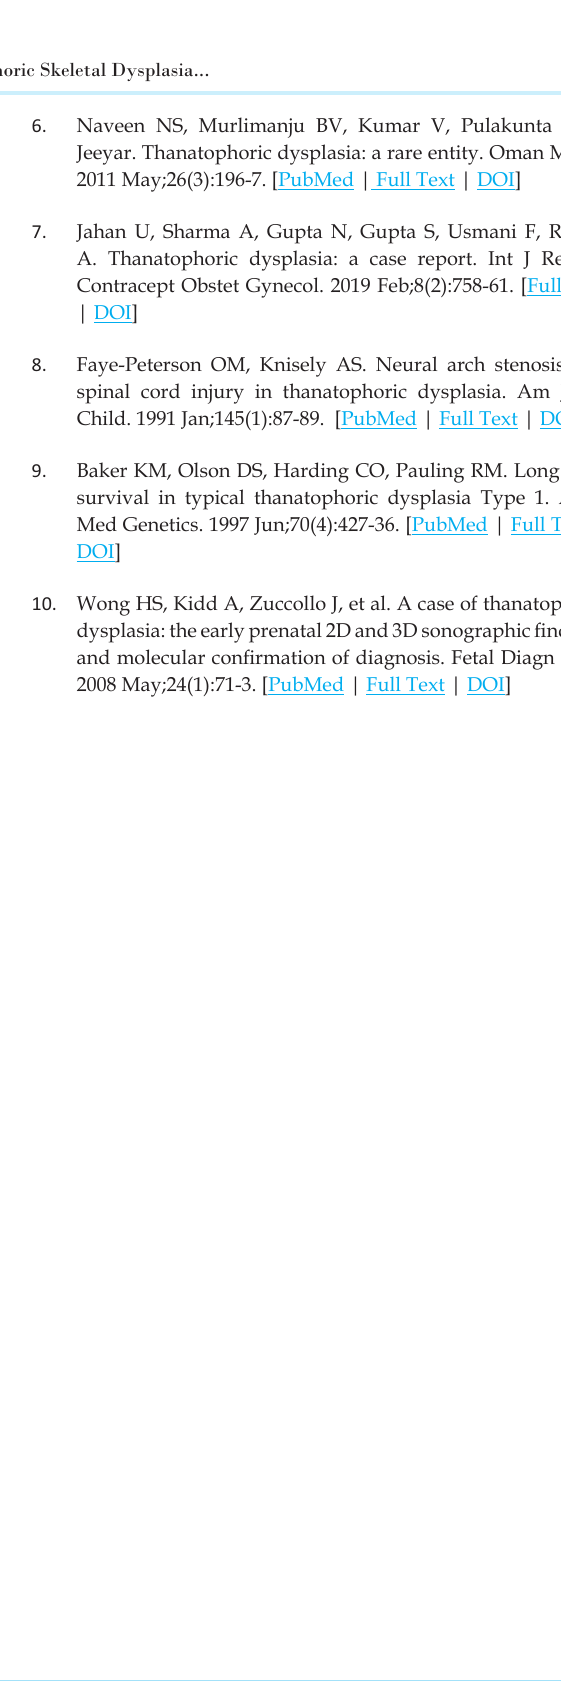
Free Full Text Articles are Available at